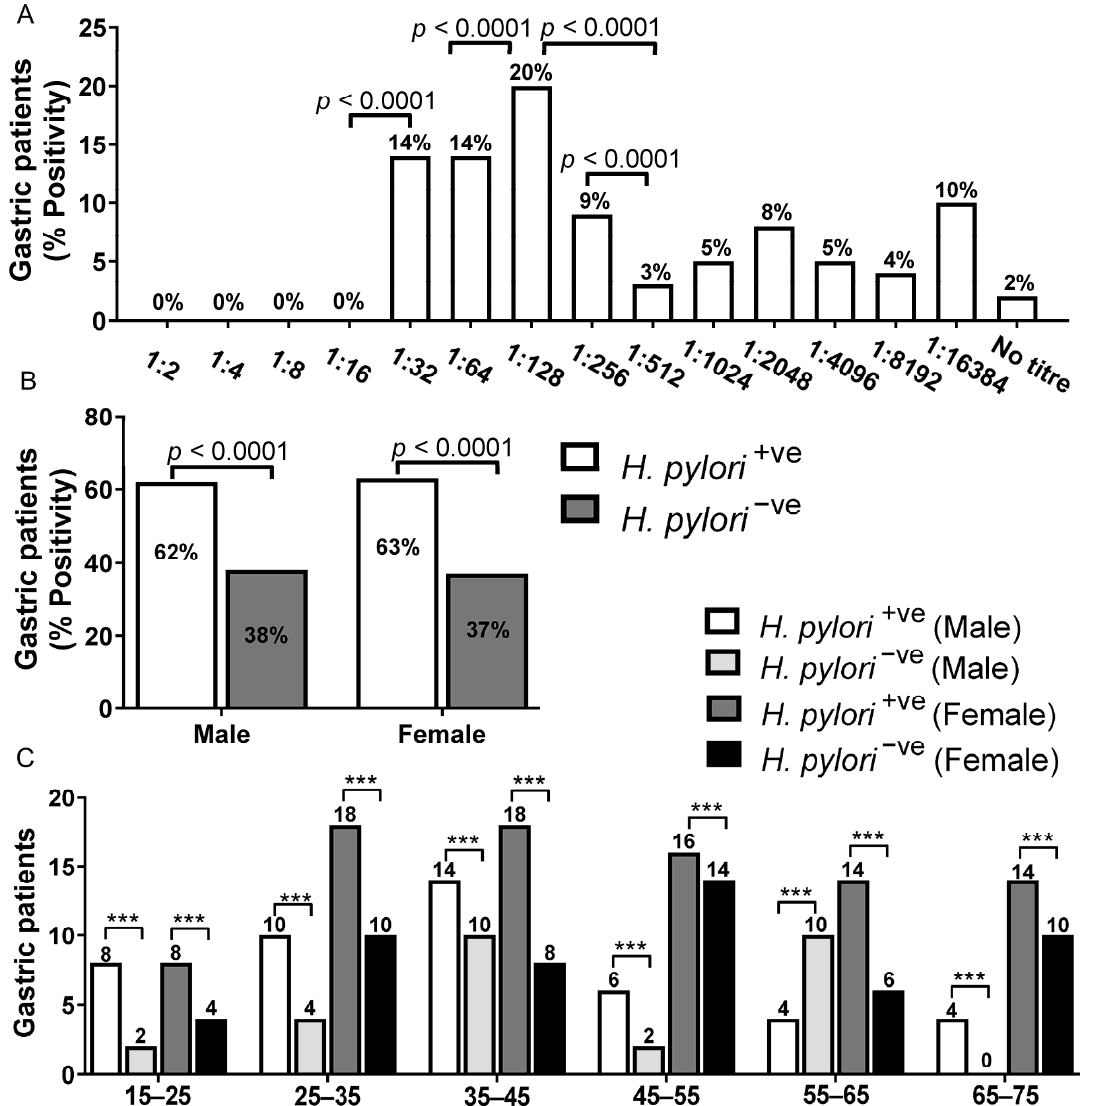
Figure 2. ( A ) Comparison of anti- H. pylori antibody titers between different positive percentages of gastroduodenal ulcer and gastritis patients by thin layer immunoassay. ( B ) Bar diagram showing high number of male positive results compared to female by TLI method. ( C ) Age wise distribution (15–75 years) of H. pylori infected gastric patients by thin layer immunoassay in reference to sex. One asterisk (*) indicates p value smaller than 0.05 ( p ,0.05). Three asterisks (***) indicate p value smaller than 0.001 ( p ,0.001).